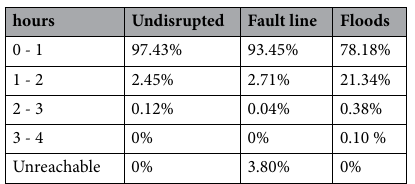
Table 1. Population accessibility variation in undisrupted and disrupted (flood and fault lines) scenarios for Lima city.